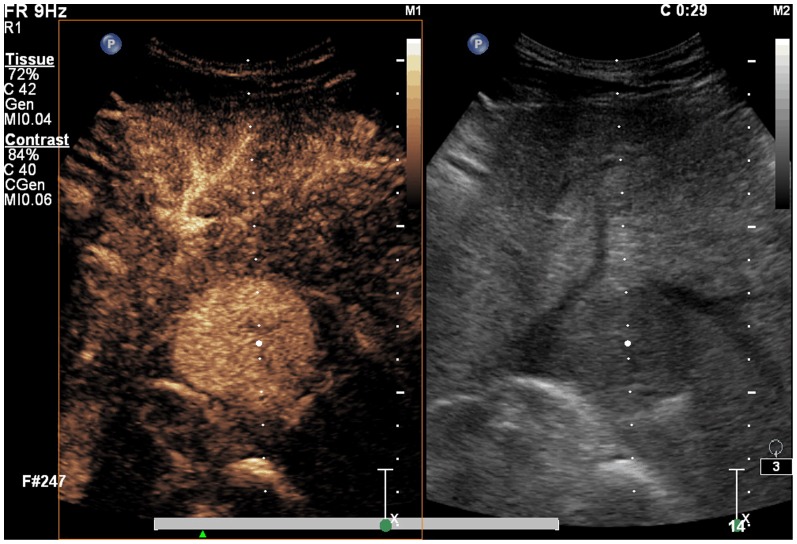
A spherical lesion with enhanced blood flow.Before treatment, a spherical lesion and enhanced blood flow is shown by contrast ultrasound.